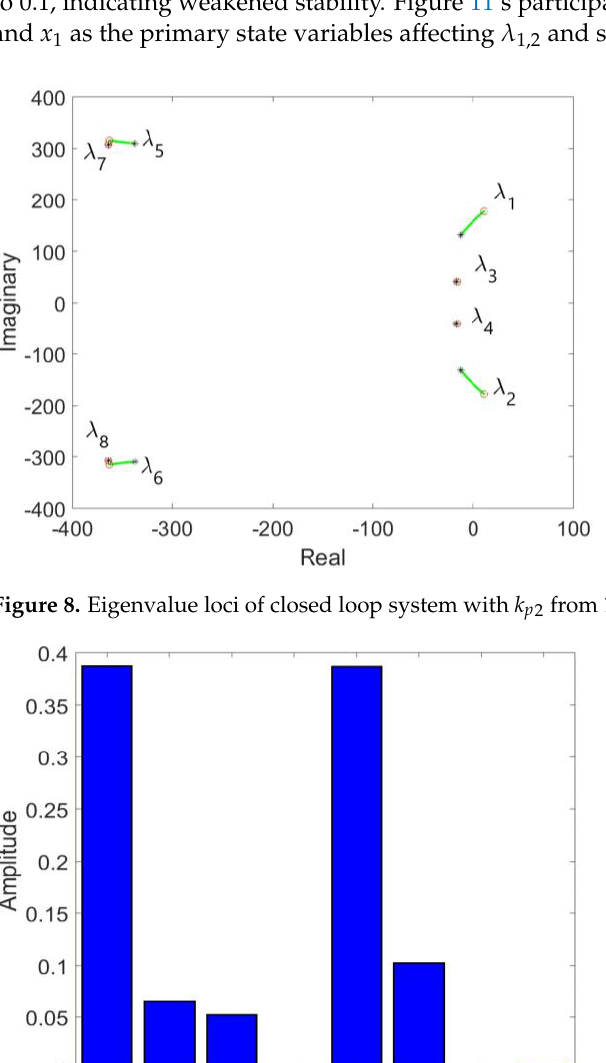
Figure 7. Participation factors of λ 5,6,7,8 with k i 1 = 0.1.